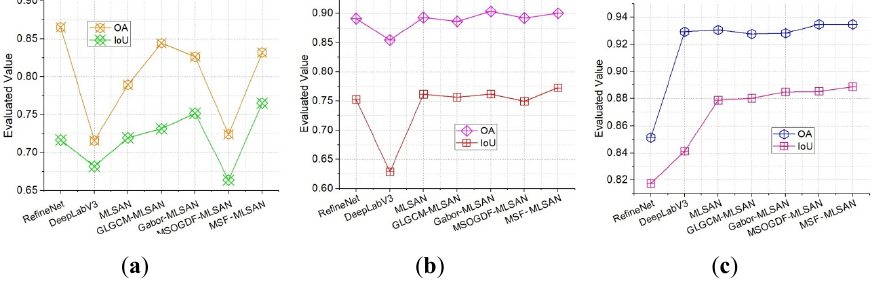
Figure 14. Classification accuracy for the three types of targets by different methods for the first experiment. ( a ) Water. ( b ) Shadow. ( c ) Background.